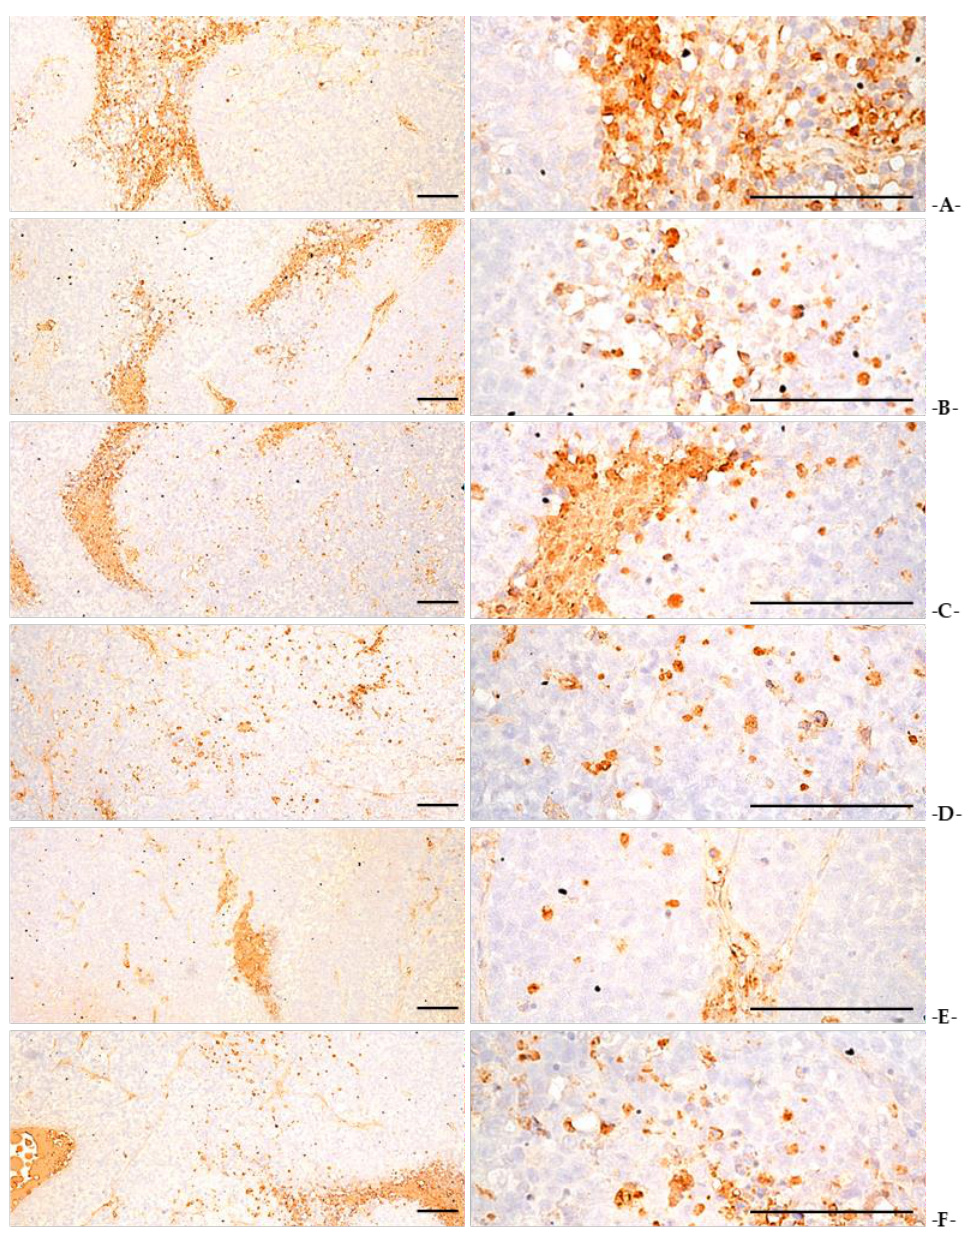
Figure 10. Representative COX-2-immunoreactivities of the tumor masses taken from NCI-H520 tumor cell xenograft mice. ( A ) = Tumor-bearing control; ( B ) = 120 mg/kg-gefitinib-single-treated rodents; ( C ) = 400 mg/kg-SKOG-single-treated rodents; ( D ) = gefitinib 120 mg/kg and SKOG 400 mg/kg; ( E ) = gefitinib 120 mg/kg and SKOG 200 mg/kg; ( F ) = gefitinib 120 mg/kg and SKOG 100 mg/kg. AR = Adenophorae Radix; KOG = Kyeongokgo ; SKOG = sasam-Kyeongokgo . COX-2 = cyclo-oxygenase-2. All avidin-biotin complex (ABC) methods. Scale bars = 100 μm.